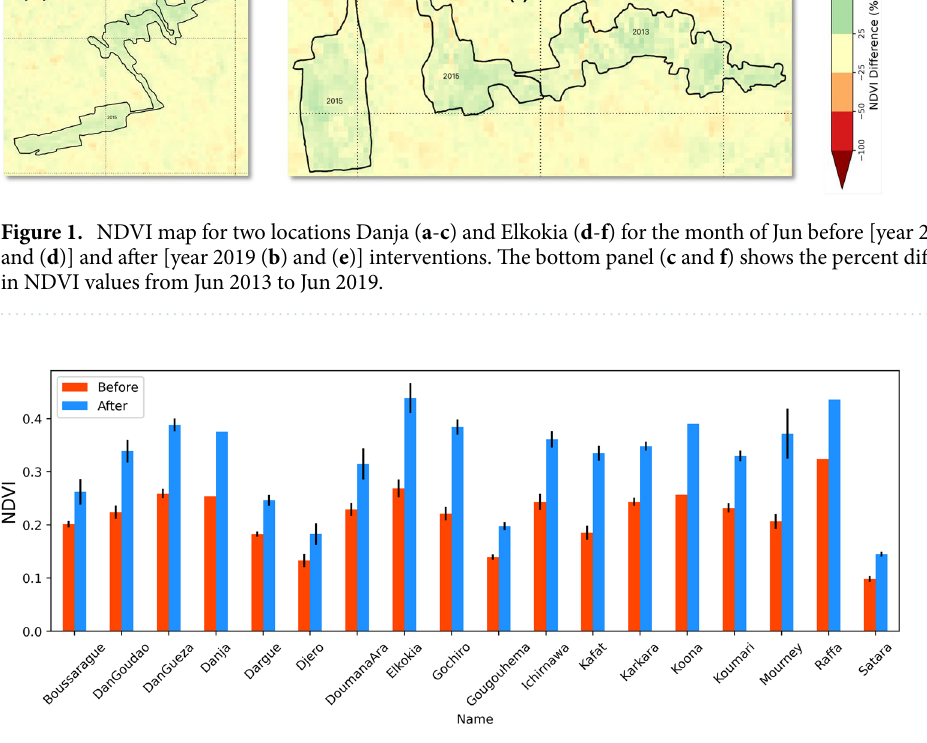
Figure 2. Mean peak NDVI across all sub-polygons for all sites intervened before and after intervention. The error bars represent the standard error in mean NDVI values from different sub-polygons within a site. [Danja, Koona and Raffa are single polygon sites, hence no error